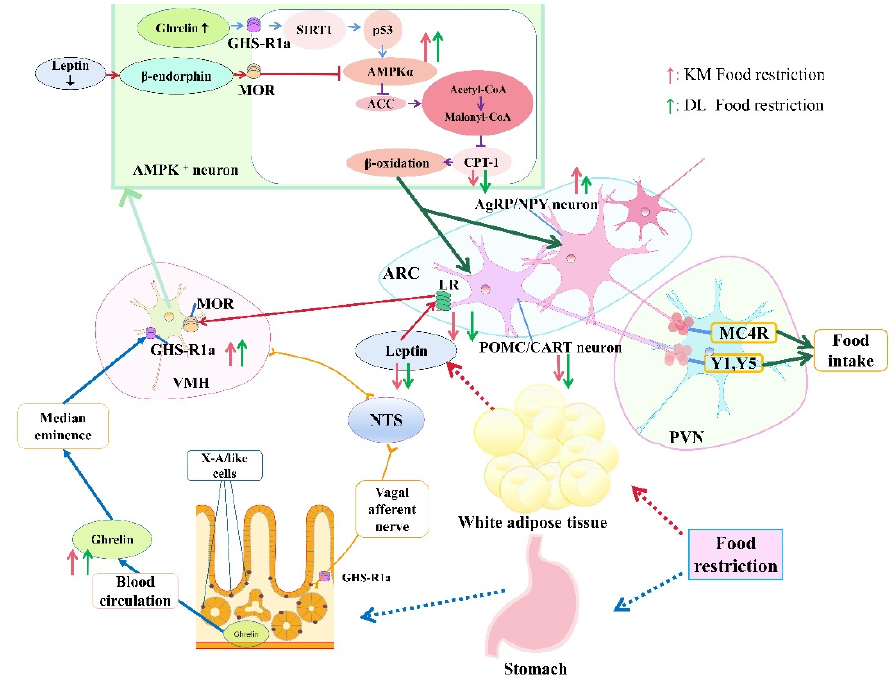
Figure 8. Roles of ghrelin and leptin in body mass regulation under food restriction based on the AMPK pathway in E. miletus from Kunming and Dali regions. The height of the arrow represents the change in the indicator between the two regions. The higher the arrow is, the greater the change is.